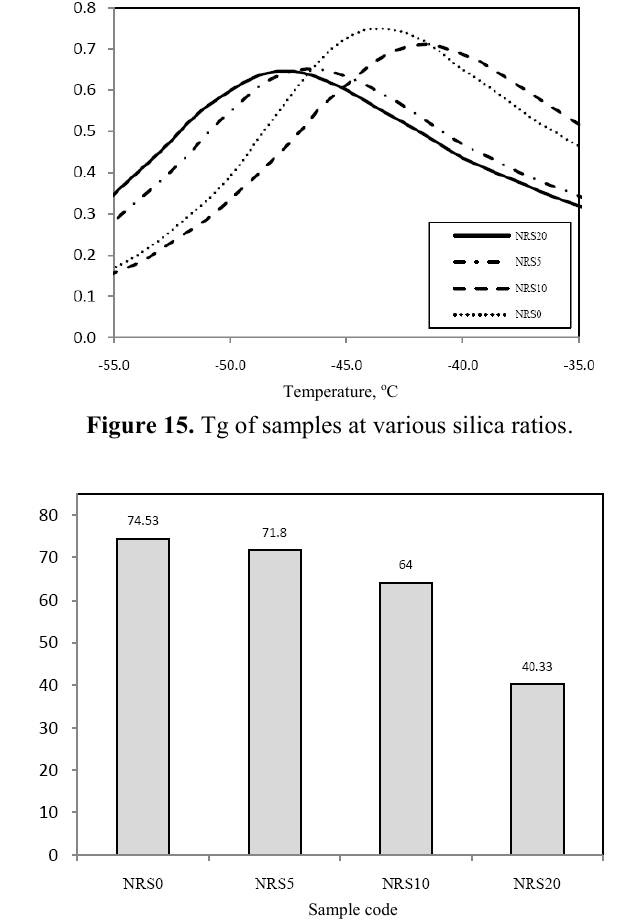
Figure 16. Heat buildup of samples at various silica